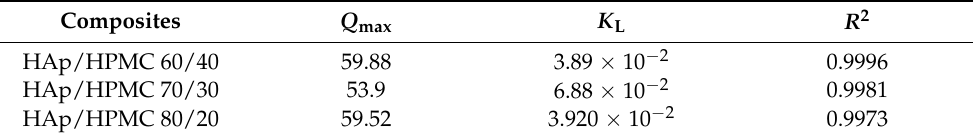
Table 3. Results using the Langmuir model of the MB adsorption isotherm on the HAp/HPMC composite. Composites Q max K L R 2 HAp/HPMC 60/40